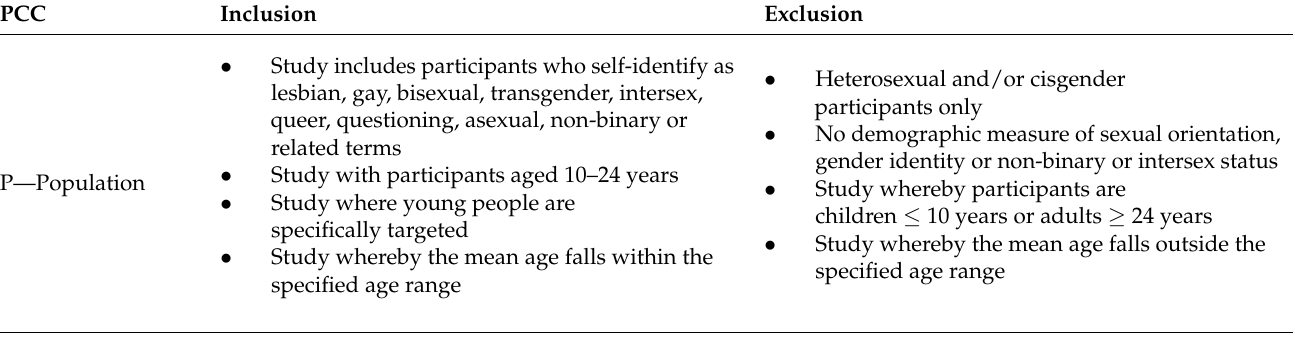
Table 1. Inclusion and exclusion criteria of study selection using PCC